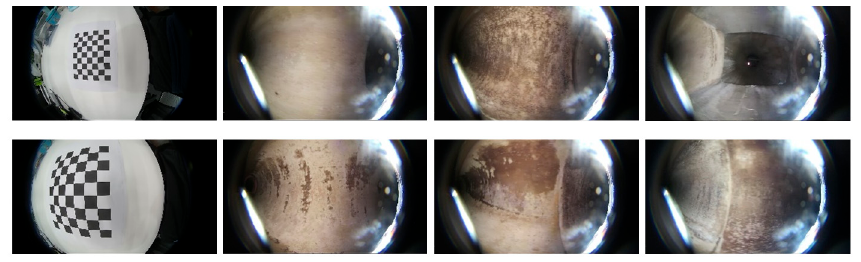
Figure 5. The fisheye images obtained by the capsule robot.